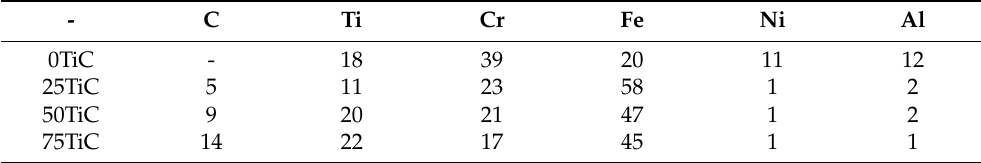
Figure 2. SEM images of surface ( a ) and cross-sections ( b , c ) of the coatings. Table 1. Elemental composition of coatings determined by EDS